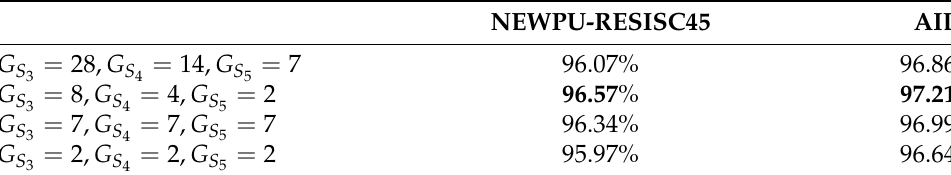
Table 2. Effect of branch granularities.